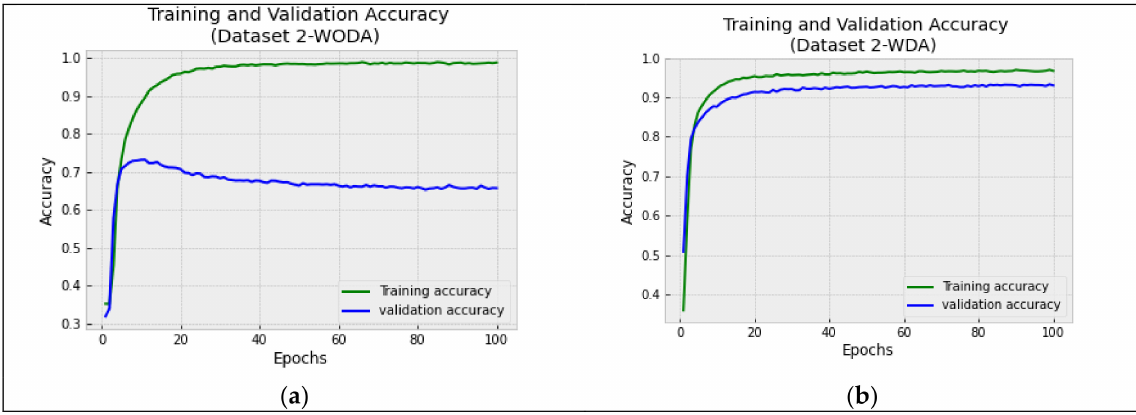
Figure 13. LSTM model validation and testing accuracy and lose (dataset 2): ( a ) model accuracy (WODA); ( b ) model accuracy